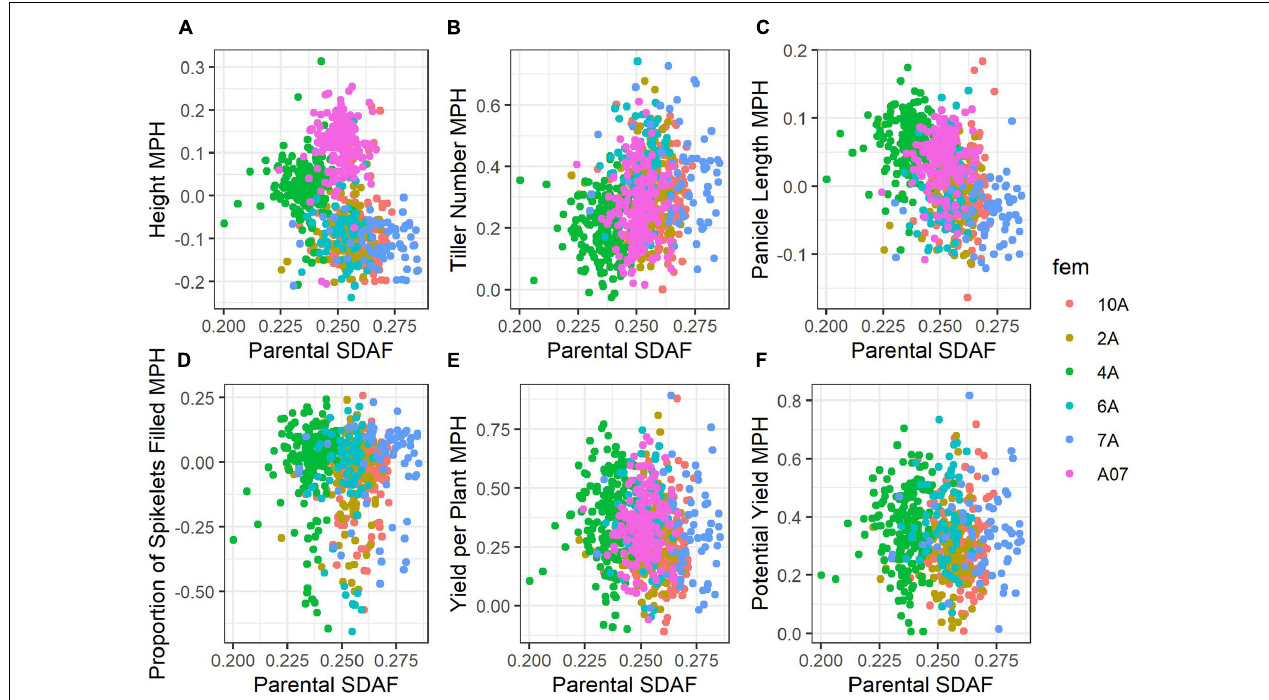
FIGURE 3 | Scatterplots of mid-parent heterosis against parental SDAF. Points are colored according to female parent. (A) Height. (B) Tiller number. (C) Panicle length. (D) Proportion grains filled. (E) Yield per plant. (F) Potential